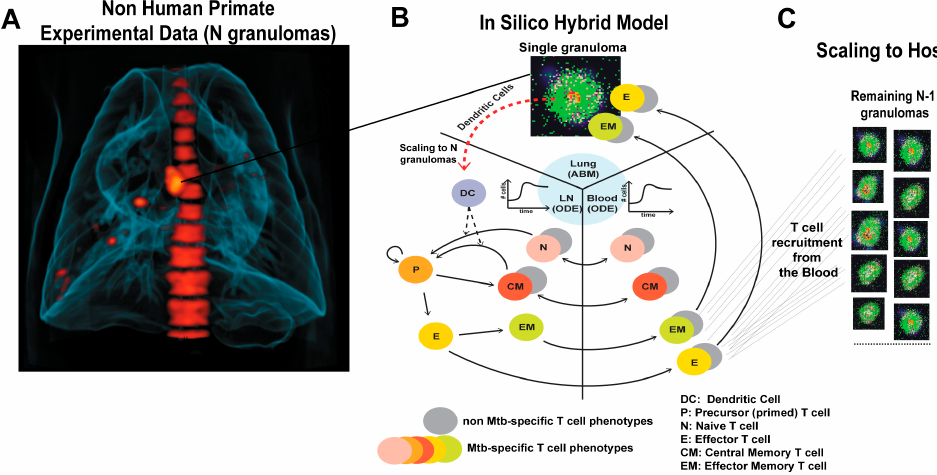
Figure 2. Scaling to host methodology. Our in silico model captures single granuloma formation in the lung. Panel ( A ) shows a PET-CT scan of the lung of an infected Non-Human Primate (NHP). An important and likely independent driver of Mtb infection outcome is inflammation. In vivo 18F-Fluorodeoxyglucose (FDG)-PET/CT signals are used to measure the extent of inflammation both in humans [3] and in non-human primates infected with Mtb [52,53]. PET-CT scan is an advanced nuclear imaging technique which combines positron emission tomography (PET) and computed tomography (CT) into one machine. A PET/CT scan reveals information about both the structure and function of cells and tissues in the body during a single imaging session. FDG is a PET probe that incorporates into metabolically active host cells. FDG avidity is calculated by standardized uptake values (SUVs), a measure of the metabolic activity of each granuloma and is corrected for granuloma size [53]. The red (“hot”) spots represent inflammation within granulomas indicating a number of granulomas are present (image courtesy of Joanne Flynn lab). A diagram of our in silico multi-compartment hybrid model is shown in Panel ( B ). An Agent-Based Model captures formation of a single granuloma in the lung, while a system of 31 ordinary differential equations (ODEs) captures the lymph node coupled to the blood dynamics of the whole host. Panel ( C ) illustrates the scaling to host methodology implemented to capture recruitment to the other granulomas. Where N-1 granuloma remain in the lung with the Nth being the one we model with GranSim.